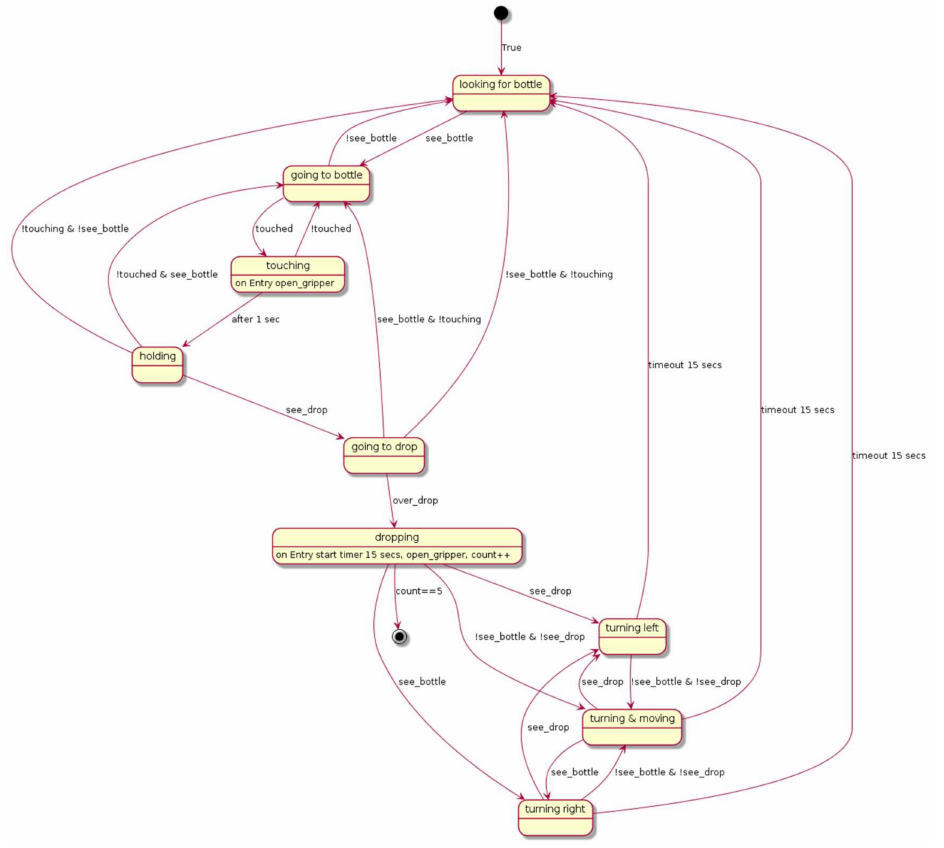
Figure 13. Statechart representing the behaviour implemented for the robot